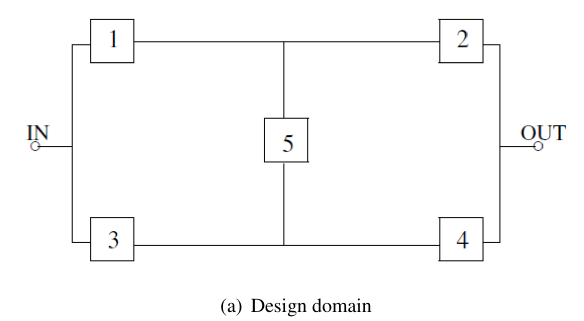
Fig. 1: A complex bridge network